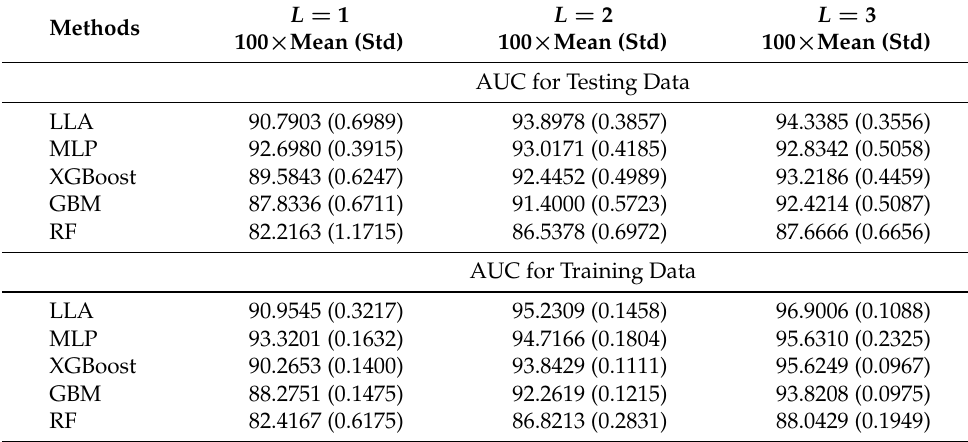
Table 6. Comparison of the number of hidden layers in LOAN and existing classifiers based on MG